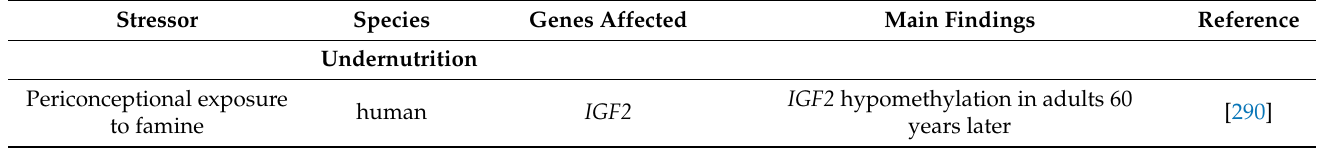
Table 2. Summary of lifestyle, diet, and environment effect on epigenetic changes in oocytes, early embryos, and their impact on offspring. “NE” indicates specific gene effects were not